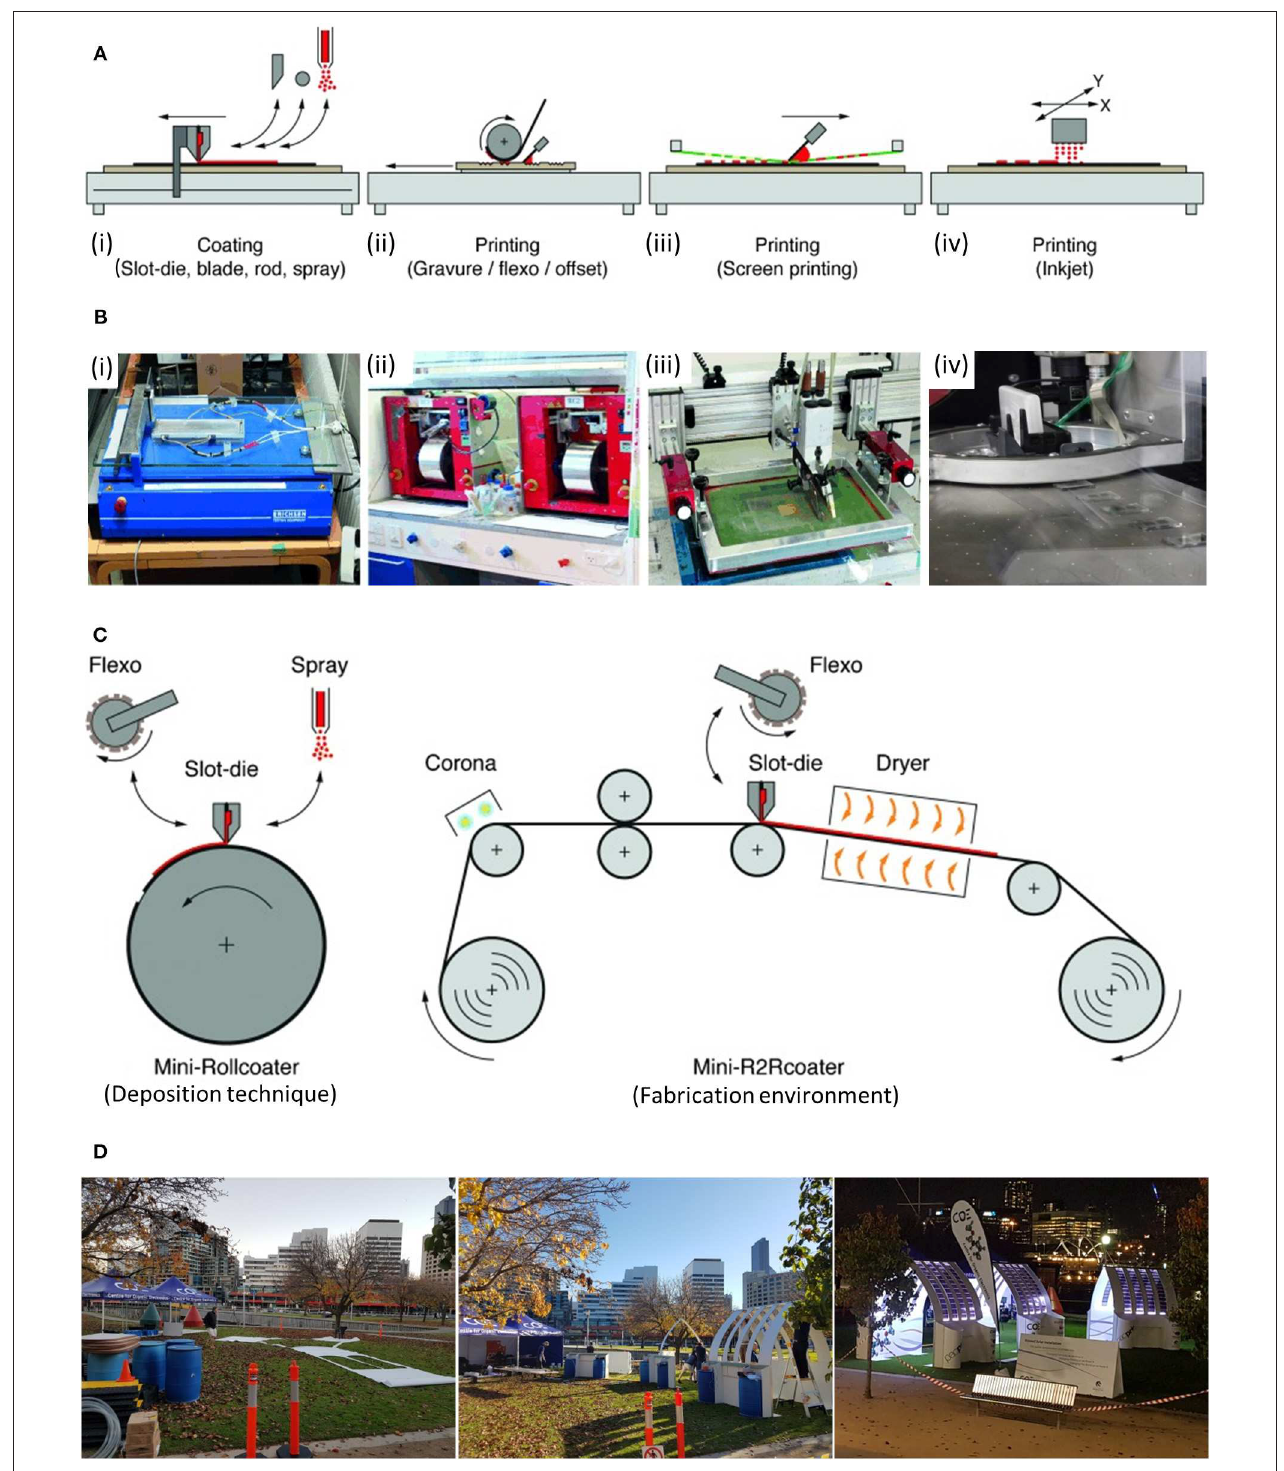
FIGURE 6 | Printing techniques and equipment for upscaling fabrication of organic semiconductor (OSC) devices. (A) Schematic illustrations of various printing and coating techniques that can be used for upscaling fabrication. (B) Photographs of laboratory equipment that match the techniques illustrated in (A) . (C) A schematic outline of an intermediate-scale roll-to-roll system for contact-free continuous deposition of OSC materials with different print techniques. Also shown is a simplified schematic of a roll-to-roll system testing inline fabrication treatments such as surface energy (corona) and thermal annealing in drying ovens. (A–C) Reproduced with permission from Hösel et al. [101]. Copyright 2015 by John Wiley and Sons. (D) Images from a recent pop-up installation of 50 m 2 of structure-integrated organic solar cells created for a demonstration in Melbourne (Australia) by researchers at the University of Newcastle.